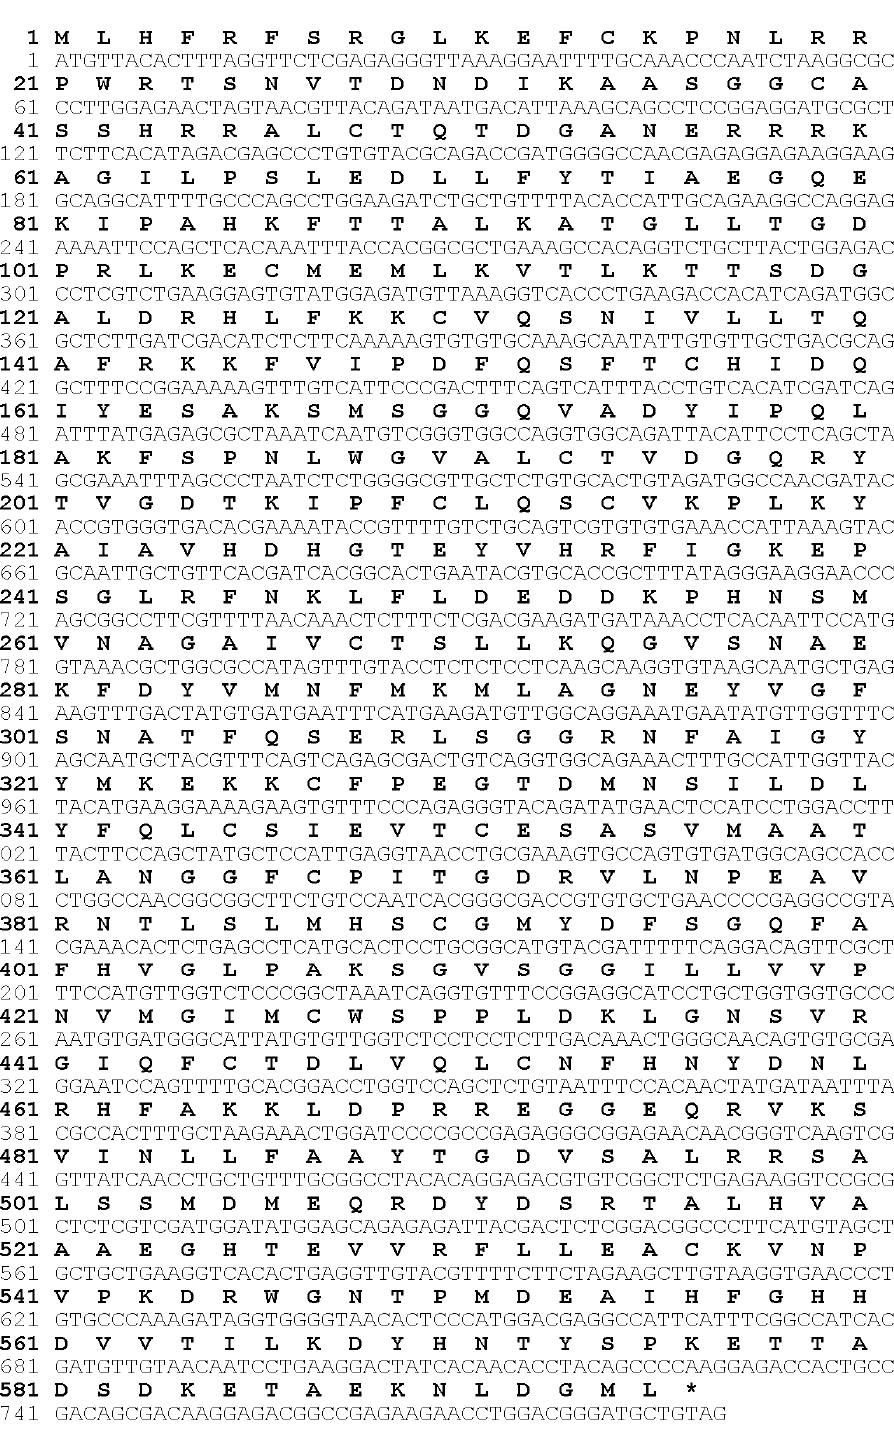
Figure 1. Nucleotide sequence and deduced amino acid sequences of the gls1 from TCC. Numbers to the left refer to nucleotides and amino acids positions. The “*” indicates the termination code. (GenBank accession number is MW435571).